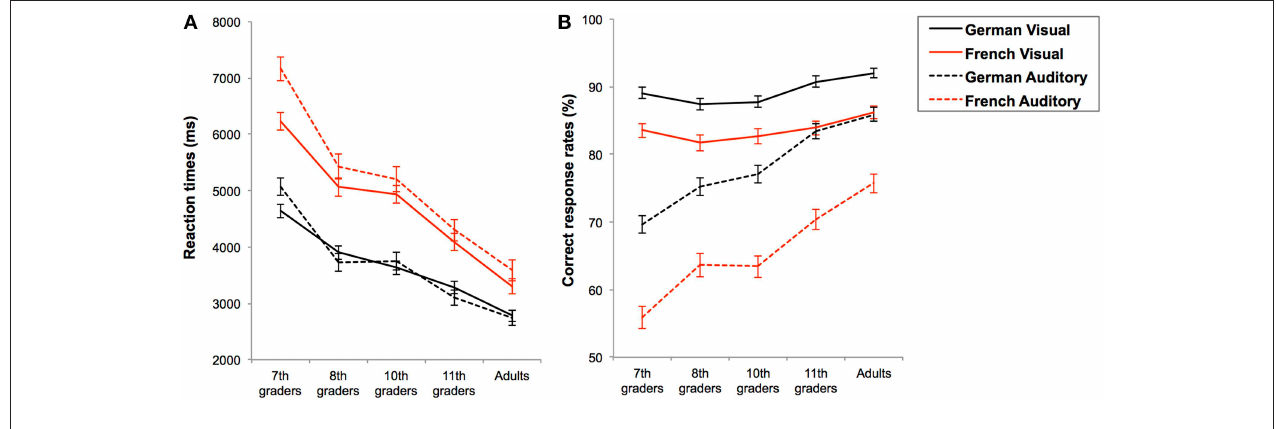
and red line for French) and in each presentation format (solid line for visual and dashed line for auditory) as a function of